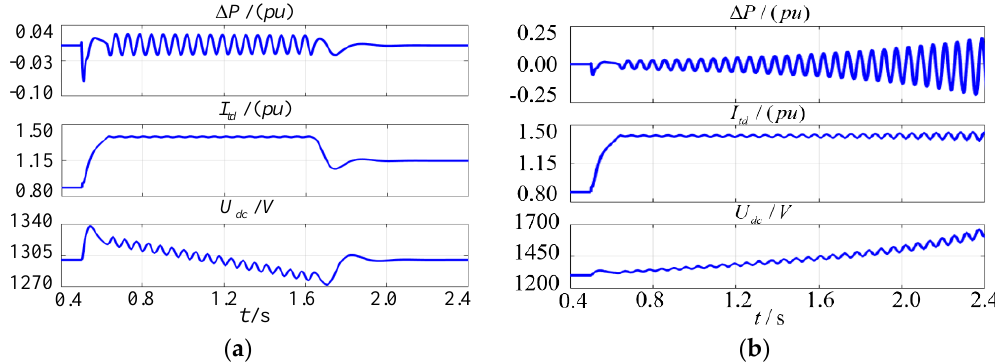
Figure 10. The effects of the current limitation: ( a ) the system is stable (current limitation is 1.38 pu ); ( b ) the system is unstable (current limitation is 1.40 pu ).